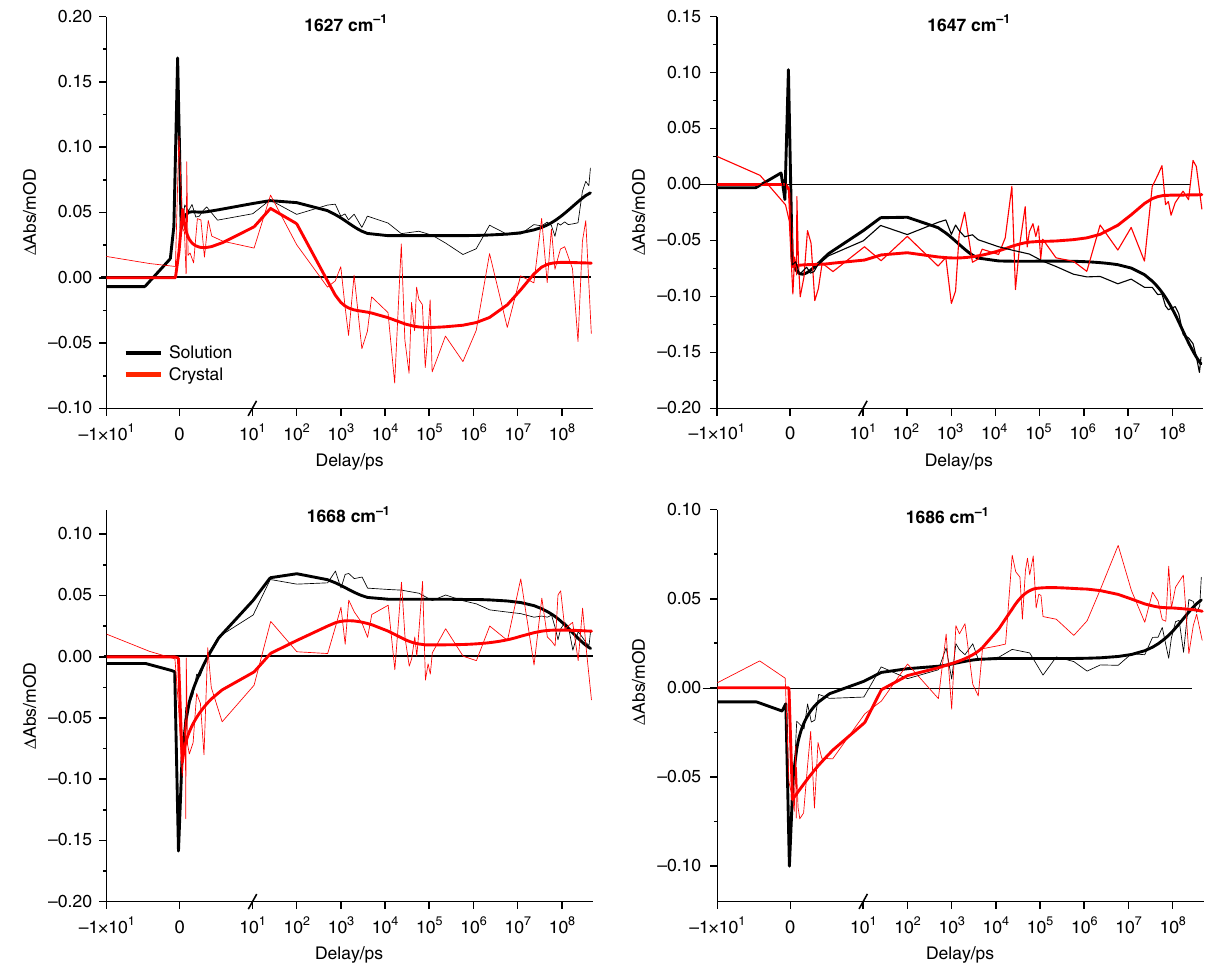
Fig. 3 Transient absorption time traces in the midinfrared. Time traces at selected wavenumbers of PYP S (black) and PYP C (red). Note that the time axis is linear until 10 ps (after the maximum of the IRF), and logarithmic thereafter. The PYP S data was scaled lower by a factor of 5 to facilitate